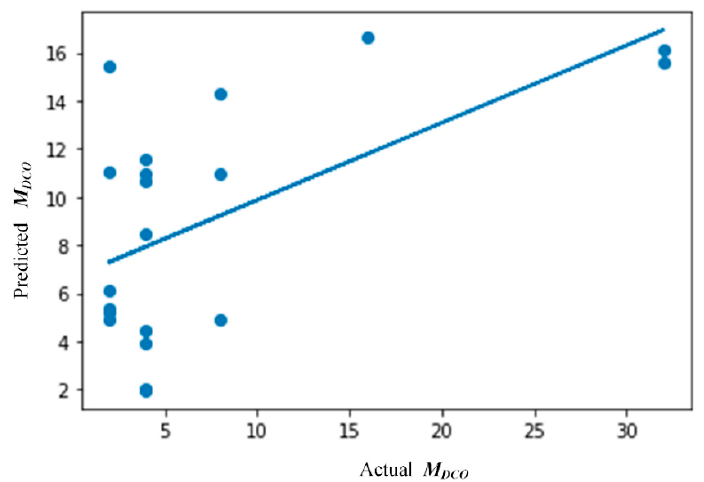
Figure 12. Predicted versus actual M DCO of dc-biased pulse amplitude modulated orthogonal frequency division multiplexing (DPO-OFDM) for the case of linear regression. Note that M DCO stands for the constellation size of DC-biased optical OFDM